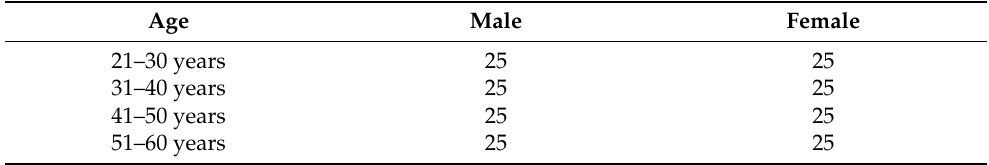
Table 1. Composition of the study